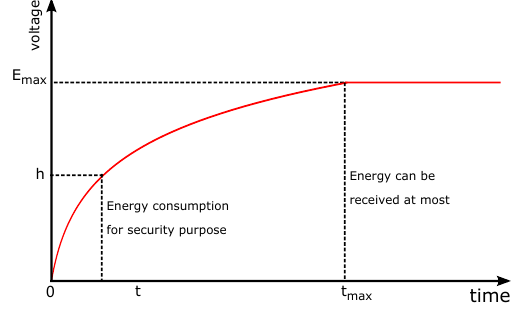
Figure 1. Energy harvesting